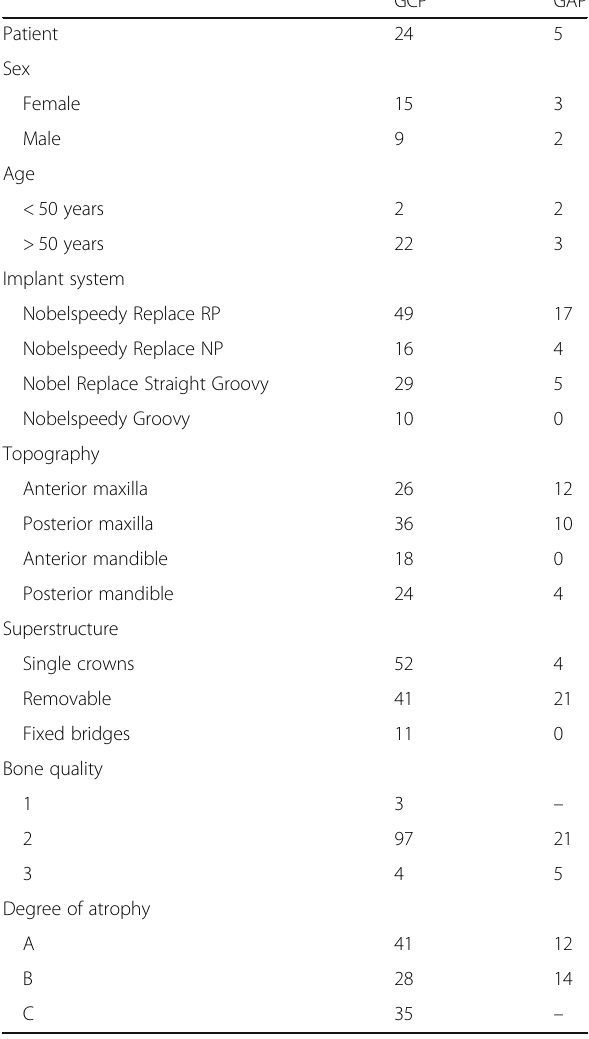
Table 1 Implants in study